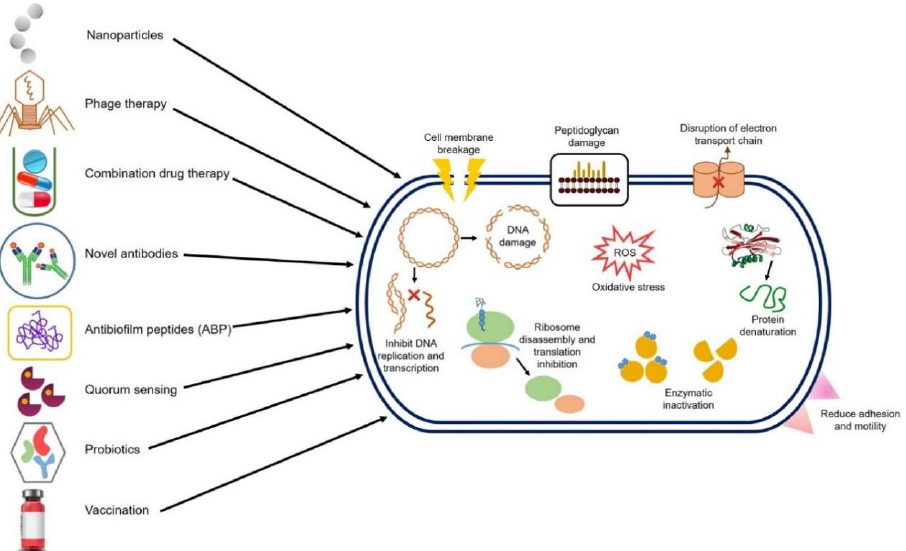
Figure 2. A pictorial presentation of various strategies, targets and effector molecules that can be used to curb the multiple drug resistance in bacterial pathogens. drug resistance in bacterial